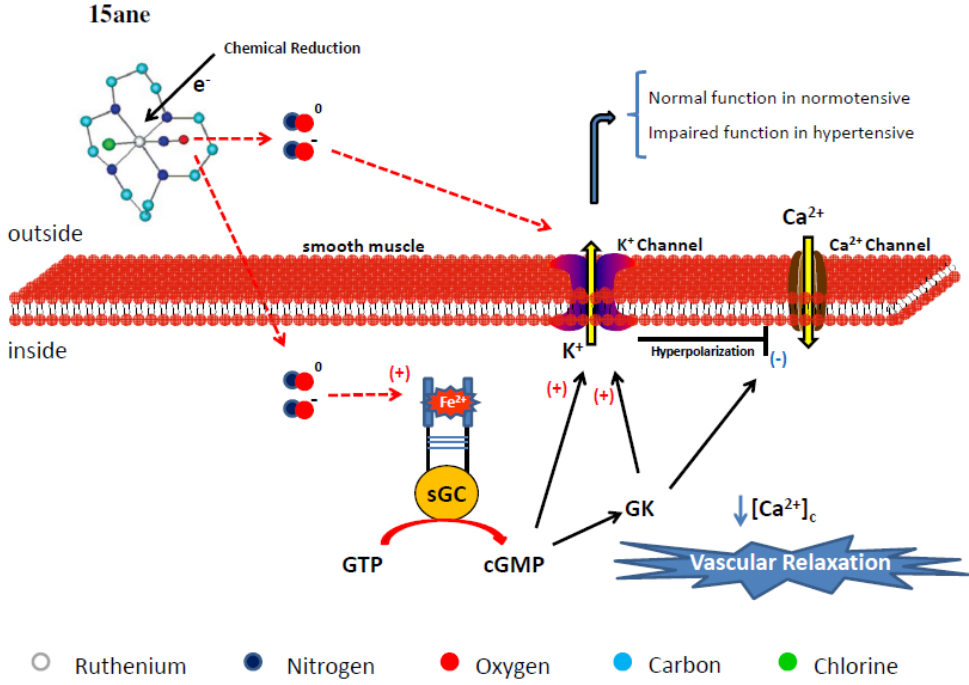
Figure 3. Proposed nitric oxide release and cellular mechanisms involved in the )NO] + (15ane). The colored circles vasodilation promoted by trans -[RuCl(15-aneN 4 represent atoms in the chemical structure. The hydrogen atom has been omitted in the structure. Legend: sGC = soluble guanylyl cyclase, GK = G Kinase Protein, Ca 2+ = calcium, = cytosolic calcium K + = potassium, [Ca 2+ ] c